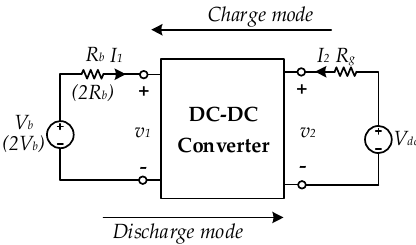
· ) stands for charge mode operating Figure 8. Converter connection network. (∙) stands for charge mode operating parameters. Figure 8. Converter connection network. (